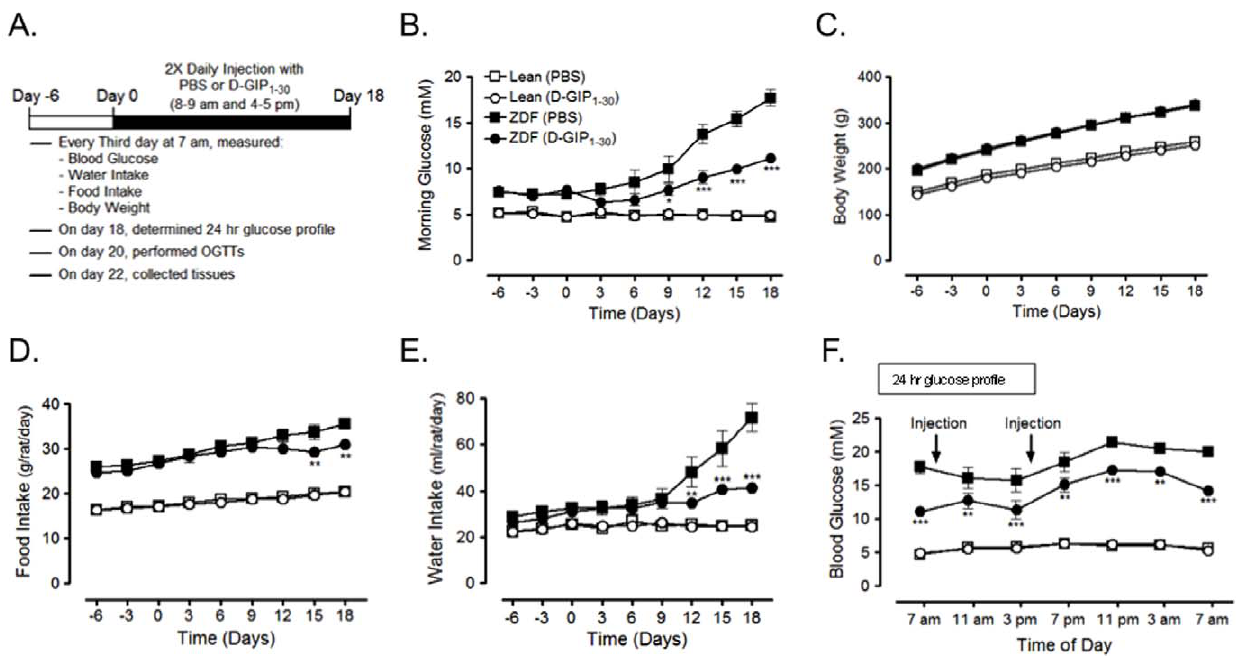
Figure 4. D-GIP 1–30 improves glycemic control in ZDF rats. A , Schematic depicting the treatment protocol in which Lean or obese ZDF rats (starting at 6 weeks of age) were monitored every 3 days from day 2 6 to day 18 and treated twice daily with PBS or D-GIP 1–30 (8 nmol/kg BW) from day 0 to day 18. B–E , Routine monitoring involved measurements of blood glucose ( B ), body weight ( C ), food intake ( D ), and water intake ( E ). Mean 6 SEM (n=6); *, p , 0.05, **, p , 0.01, ***, p , 0.001 vs ZDF rats treated with PBS. F , On day 18, blood glucose levels were determined every 3 h over a 24 h period. Mean 6 SEM (n=6); **, p , 0.01, ***, p , 0.001 vs ZDF rats treated with PBS.